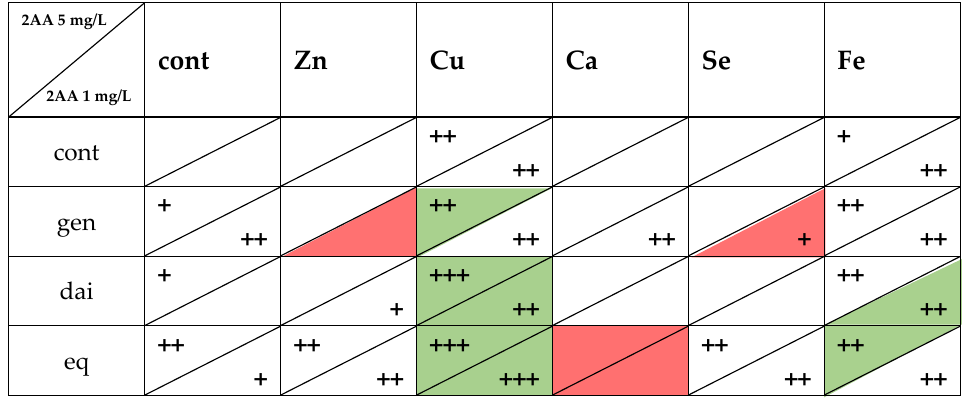
Table 7. Summary of anti-genotoxic activity of isoflavonoids, minerals and their combinations against metabolically activated promutagen 2AA (5 mg/L; 1 mg/L).